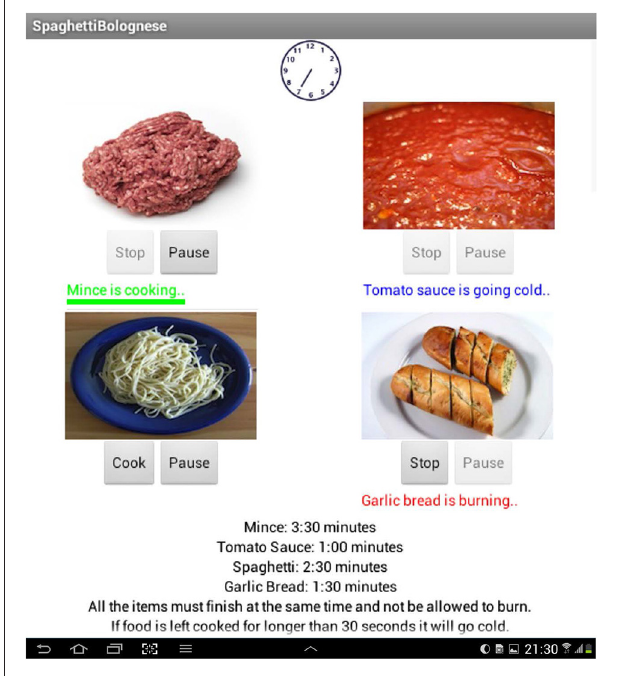
FIGURE 1 | A screenshot from the main screen of the Bolognese task at the “difficult” level with secondary laying the table distracter: (from left to right) a paused item, a finished item, a burning item, a cooking item and an item that has not been